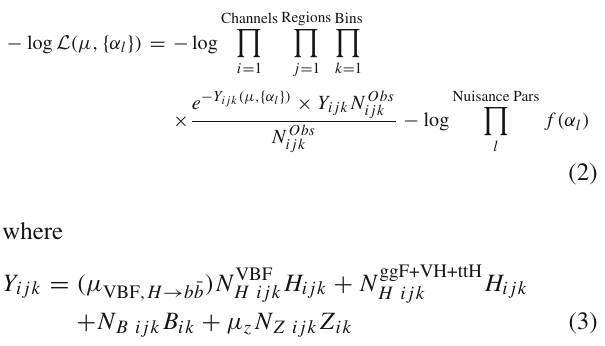
Table 2 For each channel this table shows the lower classifier score boundary of the region (min. score), as well as the expected numbers of VBF events, ggF events, and Z events, and the number of events in the Channel Region Min. score ggF Z Data sidebands